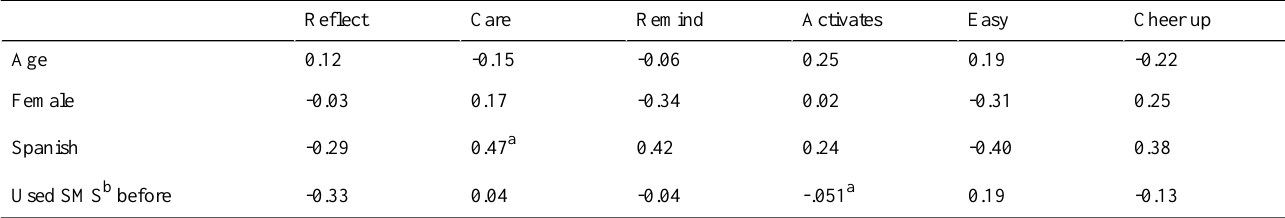
Table 3. Correlations between patient characteristics and qualitative feedback.